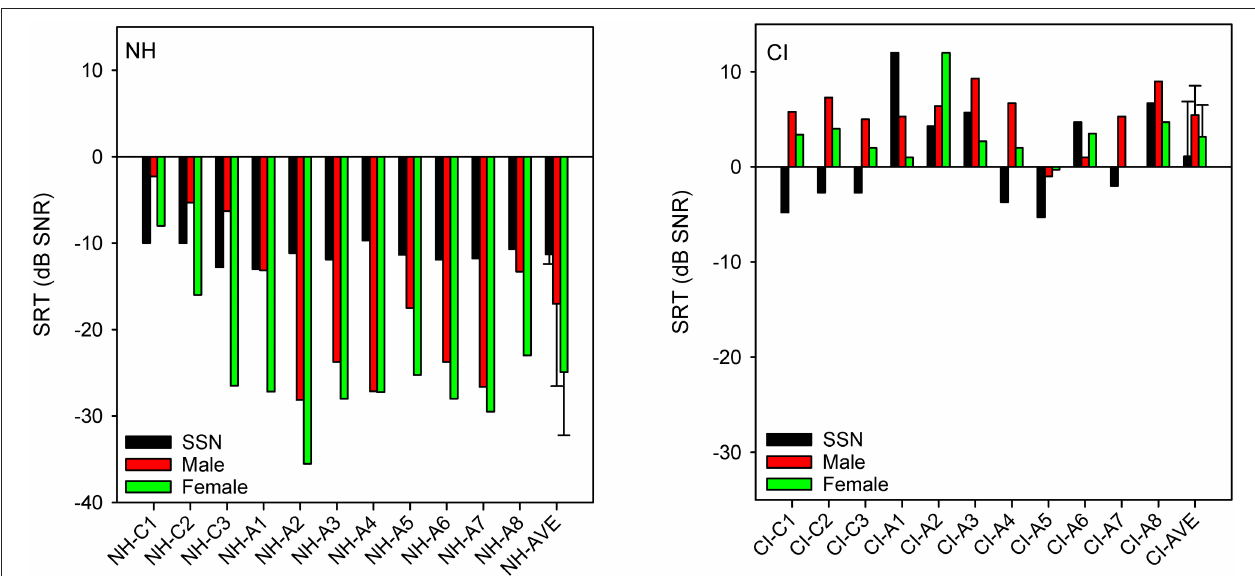
FIGURE 1 | (Left) : SRTs with SSN, competing female, or competing masker for individual NH participants; mean SRTs across NH participants are shown at right. (Right) : Same as left panel, but for CI participants. In both panels, participants are ordered in terms of age at testing, with “C” indicating child listeners and “A” indicating adult listeners. The error bars show the standard